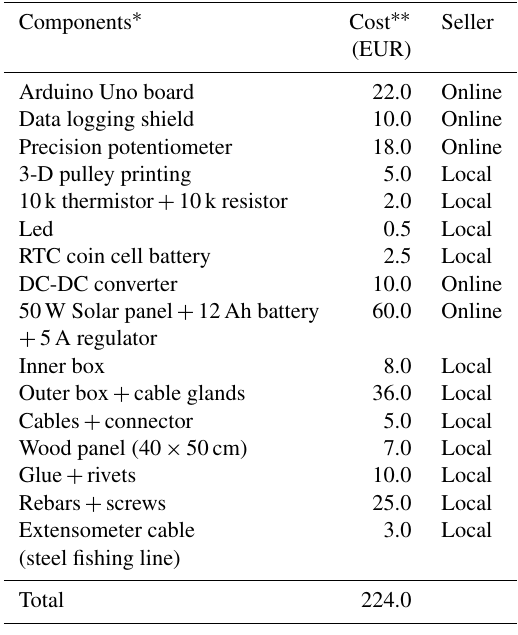
Table 1. Individual cost and seller type of each component of the monitoring